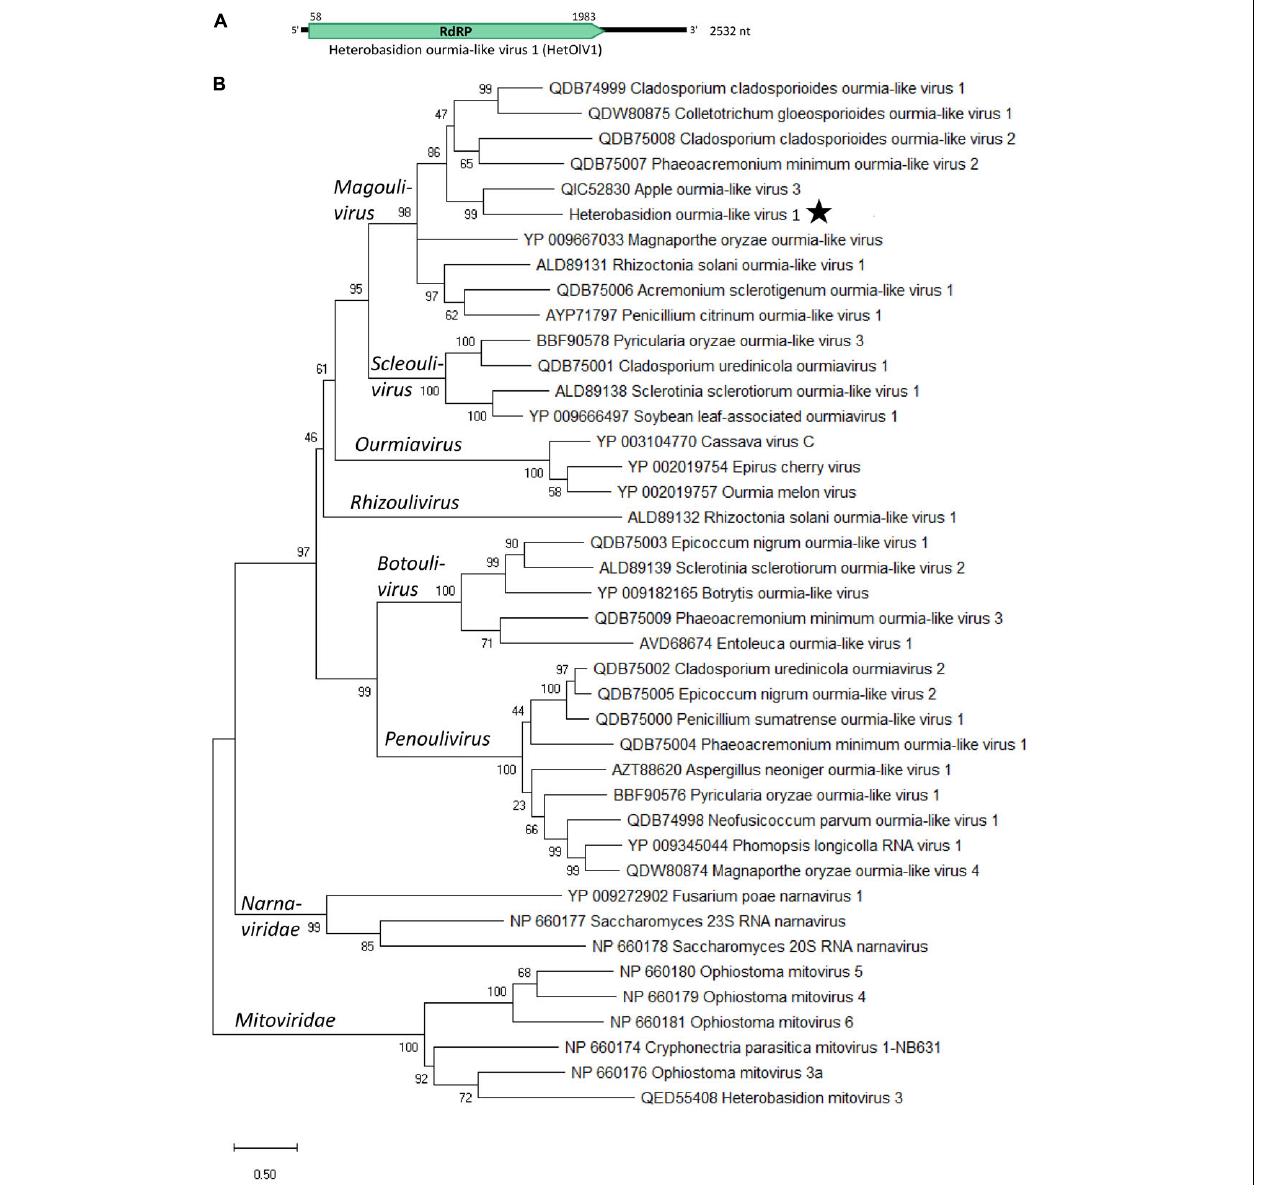
FIGURE 3 | Genome organization and phylogenetic analysis of Heterobasidion ourmia-like virus 1 (HetOlV1). (A) Schematic presentation of HetOlV1 genome with UTRs and predicted ORF with translation initiation and termination site. (B) Phylogenetic tree including members of family Botourmiaviridae and exemplar isolates of Mitoviridae and Narnaviridae based on an alignment of aa sequences of the RdRP encoding ORF generated using MAFFT v7.450 with Blosum62 substitution matrix. Evolutionary analyses were conducted in MEGA X (Kumar et al., 2018) with 500 bootstrap repeats (the percentage of trees in which the associated taxa clustered together is shown next to the branches). The evolutionary history was inferred by using the Maximum Likelihood method and Le_Gascuel_2008 model (Le and Gascuel, 2008). A discrete Gamma distribution was used to model evolutionary rate differences among sites (four categories +G +I). A star denotes the virus strain from Heterobasidion parviporum